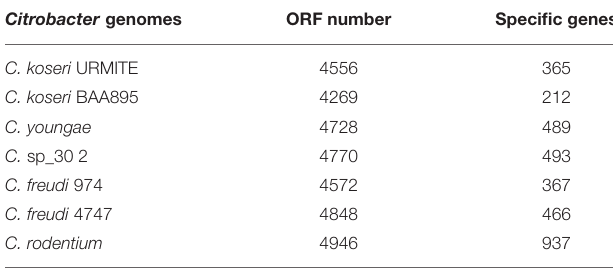
TABLE 2 | Strain-specific